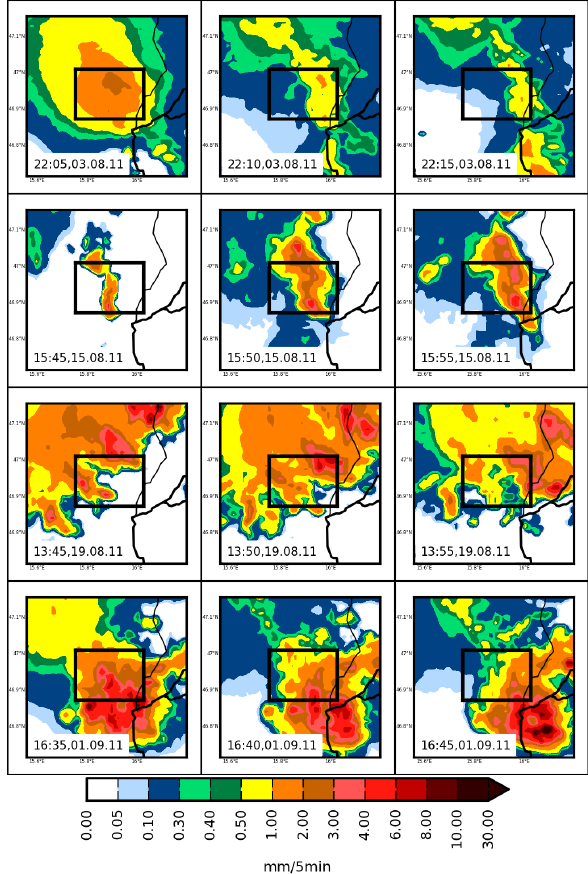
Figure 6. Spatio-temporal distribution of rapid-INCA precipitation (mm/5min) in the region of the WegenerNet indicated by the black rectangle (time is given in UTC).